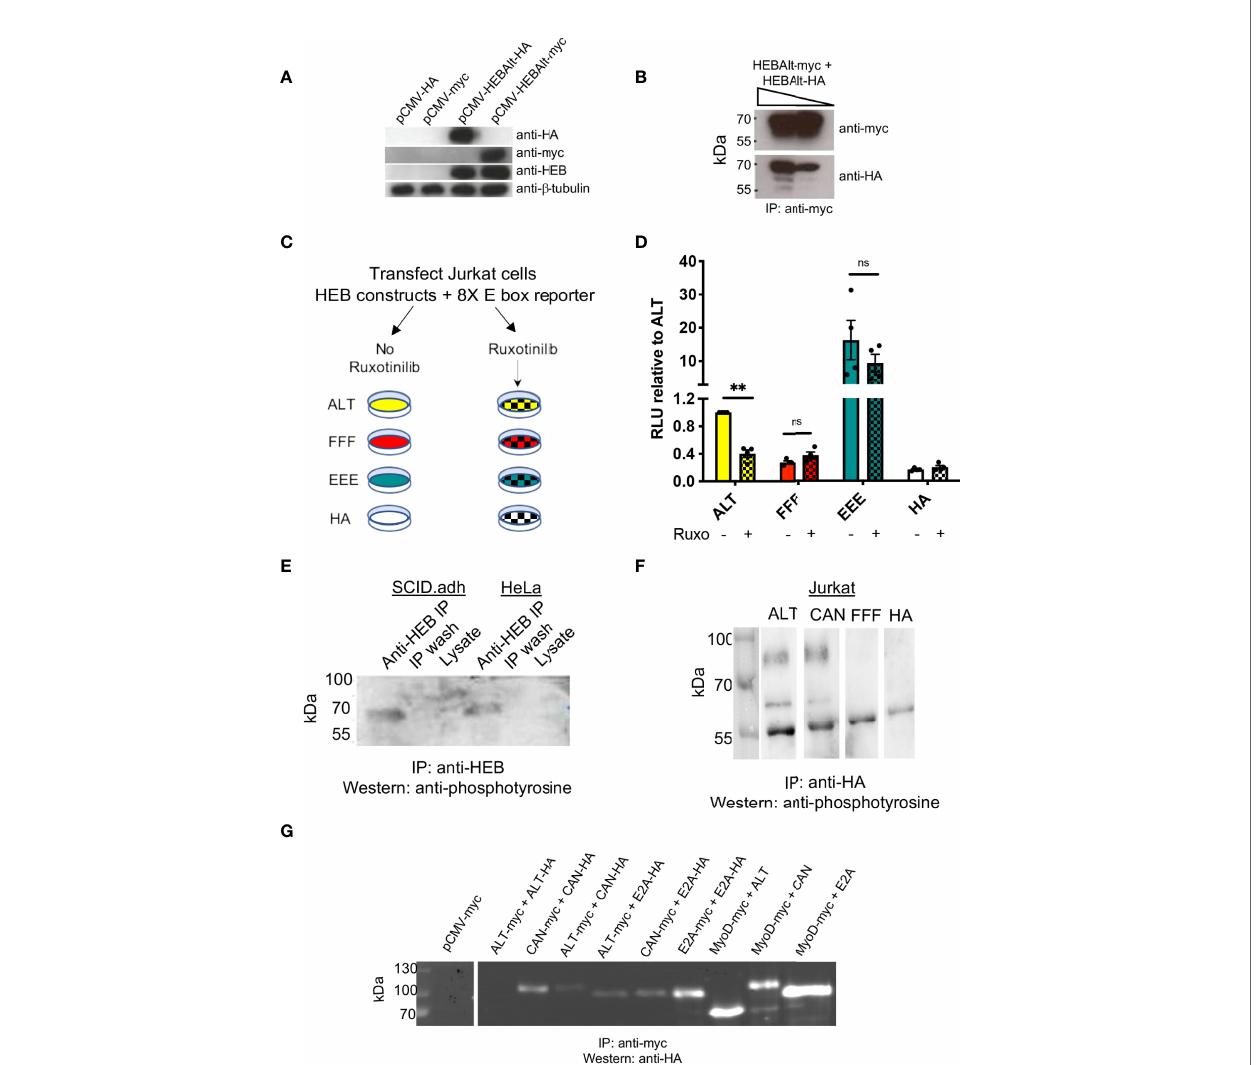
FIGURE 3 | HEBAlt transcriptional activity is decreased by JAK inhibition. (A) Western blot of lysates from HEK293T cells transfected with HEBAlt-HA, HA empty vector (pCMV-HA), HEBAlt-myc, or myc empty vector (pCMV-myc) expression constructs probed with anti-HA, anti-myc, anti-HEB (A20) or b -tubulin as a loading control. (B) Western blots of HEK293T lysates from co-IPs of HEBAlt-HA and HEBAlt-myc, using anti-myc antibodies for co-IP and anti-HA antibodies for Western protein detection, at a higher (left) or lower (right) concentration of lysate (triangle). (C) Diagram of JAK inhibition experimental design. Jurkat cells were co-transfected with HEBAlt (ALT; yellow), FFF (red), EEE (green) or HA empty vector (white), and 8X E box Fire fl y luciferase and Renilla luciferase constructs. Cells were cultured with (checked) or without ( fi lled) the pan-JAK inhibitor Ruxotinilib (Ruxo) for two days at 1 mM, followed by dual luciferase assay. (D) Activation of the reporter construct as measured by dual luciferase assay. The Y-axis depicts relative luciferase units (RLU) of Fire fl y to Renilla luciferase values normalized to ALT. **P < 0.001, ns, non- signi fi cant. (E) Detection of endogenous tyrosine phosphorylated protein in the mouse pro-T cell line SCID.adh and human HeLa cells after immunoprecipitation with anti-HEB antibodies, assessed by probing of Western blot with anti-phosphotyrosine antibodies. (F) Western blot of lysates extracted from Jurkat cells transfected with ALT or CAN, IP ’ d with anti-HA, and probed with anti-phosphotyrosine antibodies. (G) Expression proteins epitope tagged with myc or HA were contransfected into HEK293T cells and co-immunoprecipitated with anti-myc. Lysates were analyzed by Western blots probed with anti-HA. The discrepancy between ALT-ALT dimerization seen in (B) versus (G) is likely due to the exposure times on the different blots, since a far longer detection time was necessary to observe ALT-ALT dimers, and the blot in (G) was optimized to visualize the range of intensity for the other